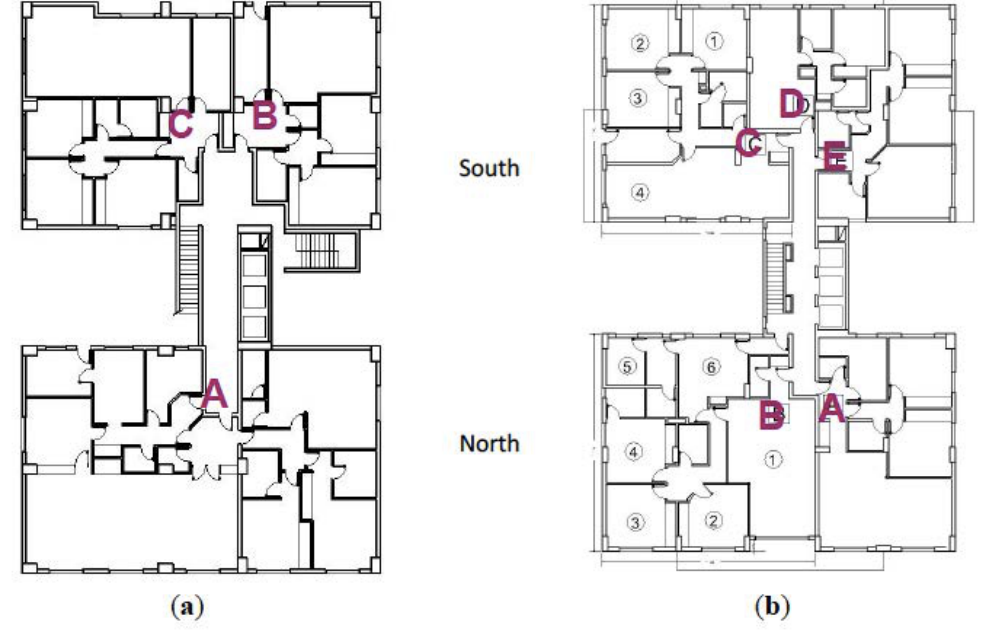
Figure 3. Gemelius Building: ( a ) first level of apartments; and ( b ) from third to twelfth floor.